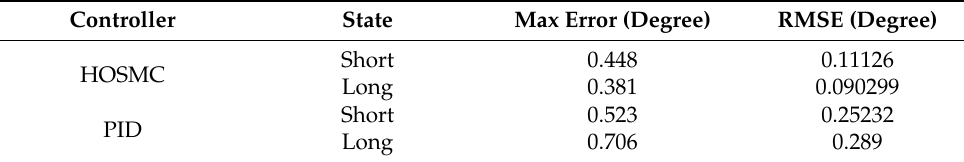
Table 8. Comparison table of controlling fixed moment of inertia of a robot arm.